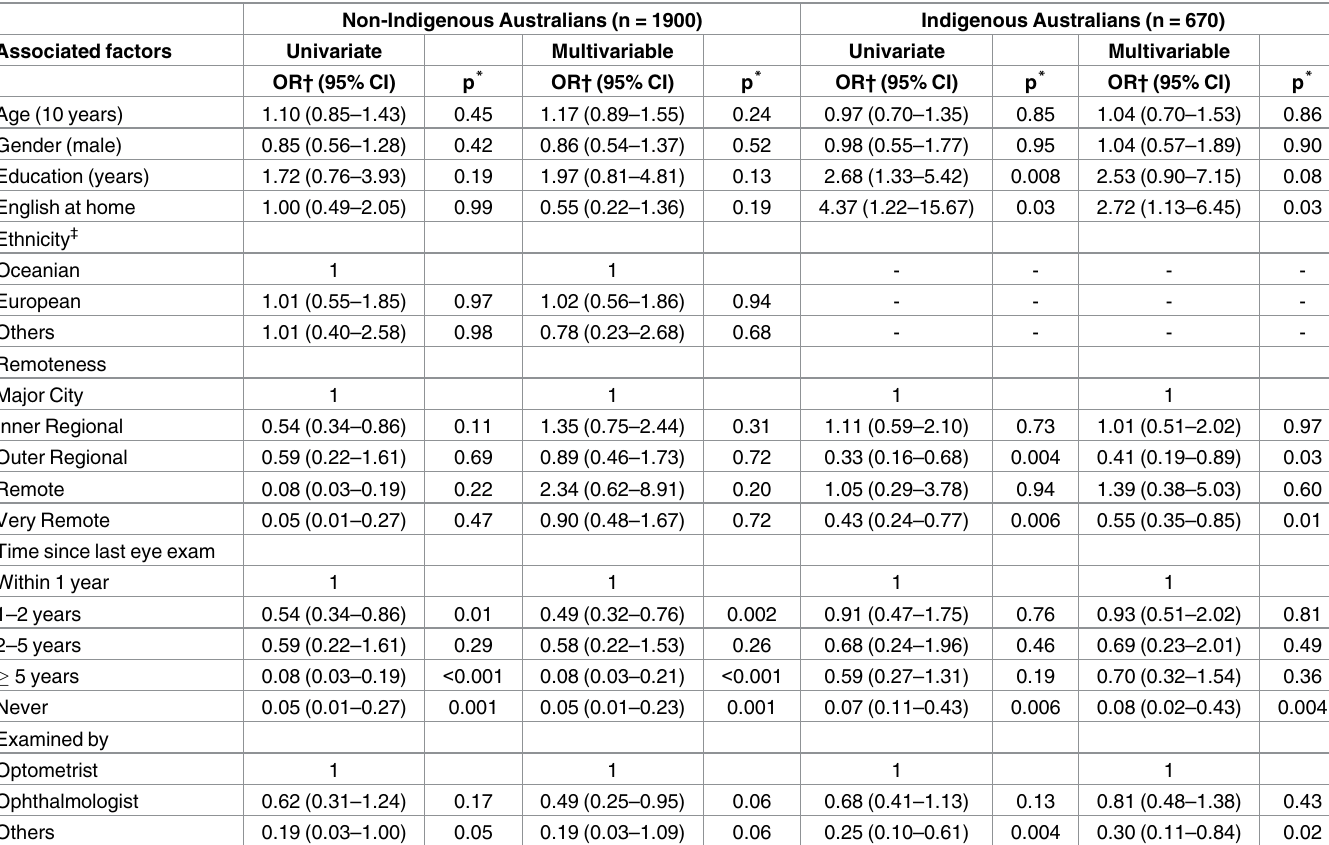
Table 3. Multivariable analysis of factors associated with treatment of refractiveerror in Indigenous and non-Indigenous Australians.